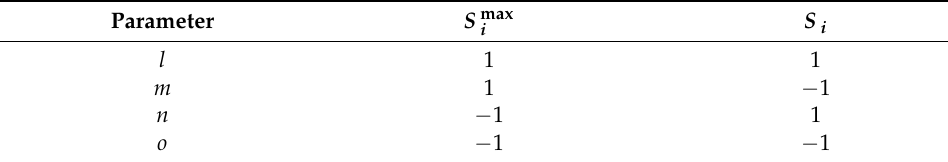
Table 4. Neuron state for parameters in similarity